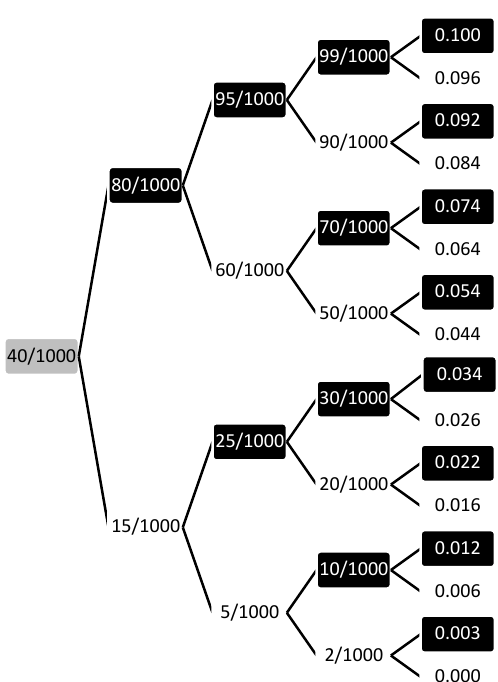
Figure 2: Interval division approach in the SG